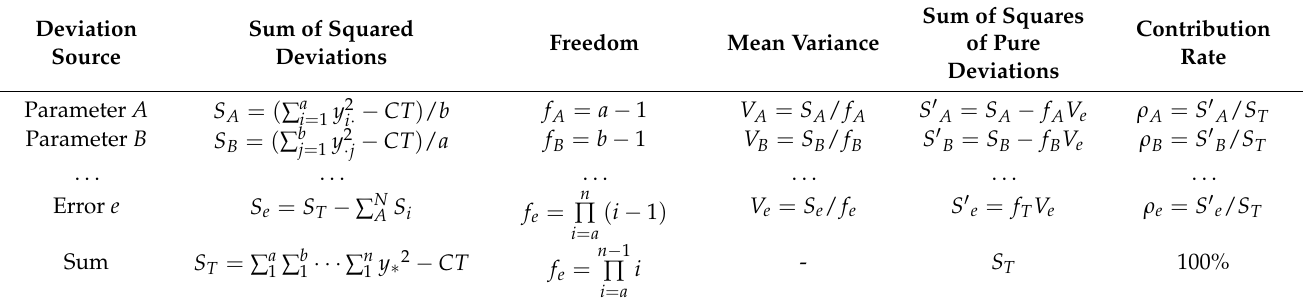
Figure 5. Procedure of the surrogate model construction.